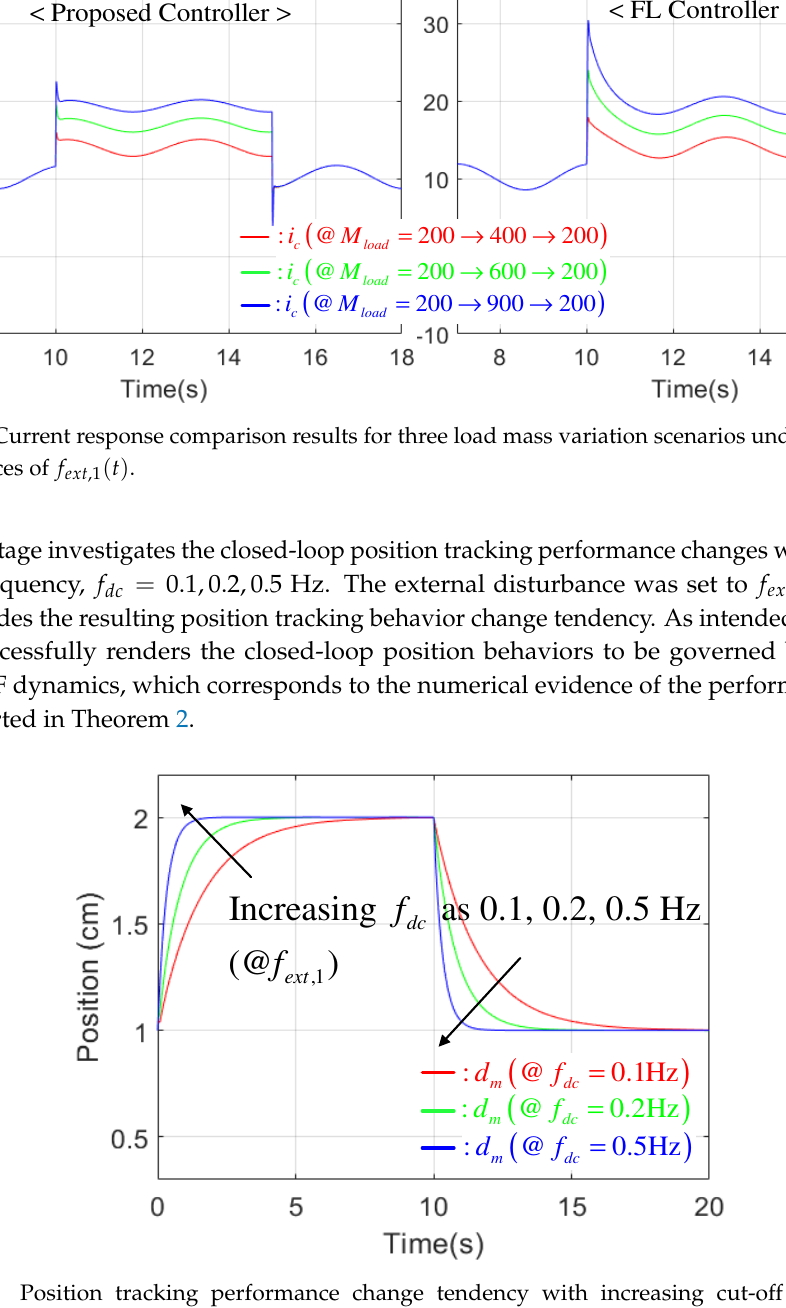
Figure 8. Position tracking performance change tendency with increasing cut-off frequency, f dc = 0.1,0.2,0.5